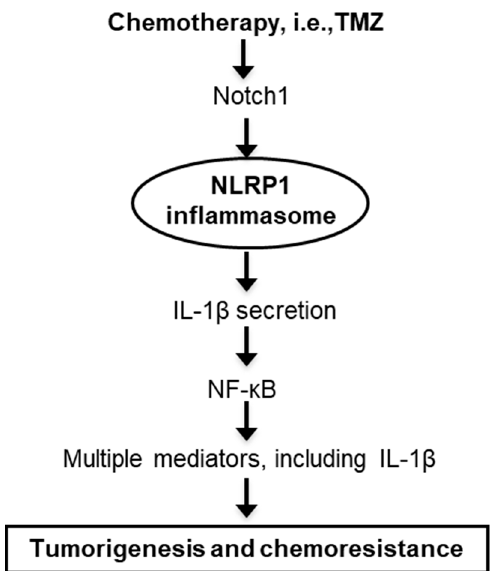
Figure 8. Flow-chart model proposal to explain the NLRP1 involvement in melanoma chemoresistance. NLRP1 is a component of the activated and NF- κ B-associated signaling pathways responsible for resistance following chemotherapeutic assaults.